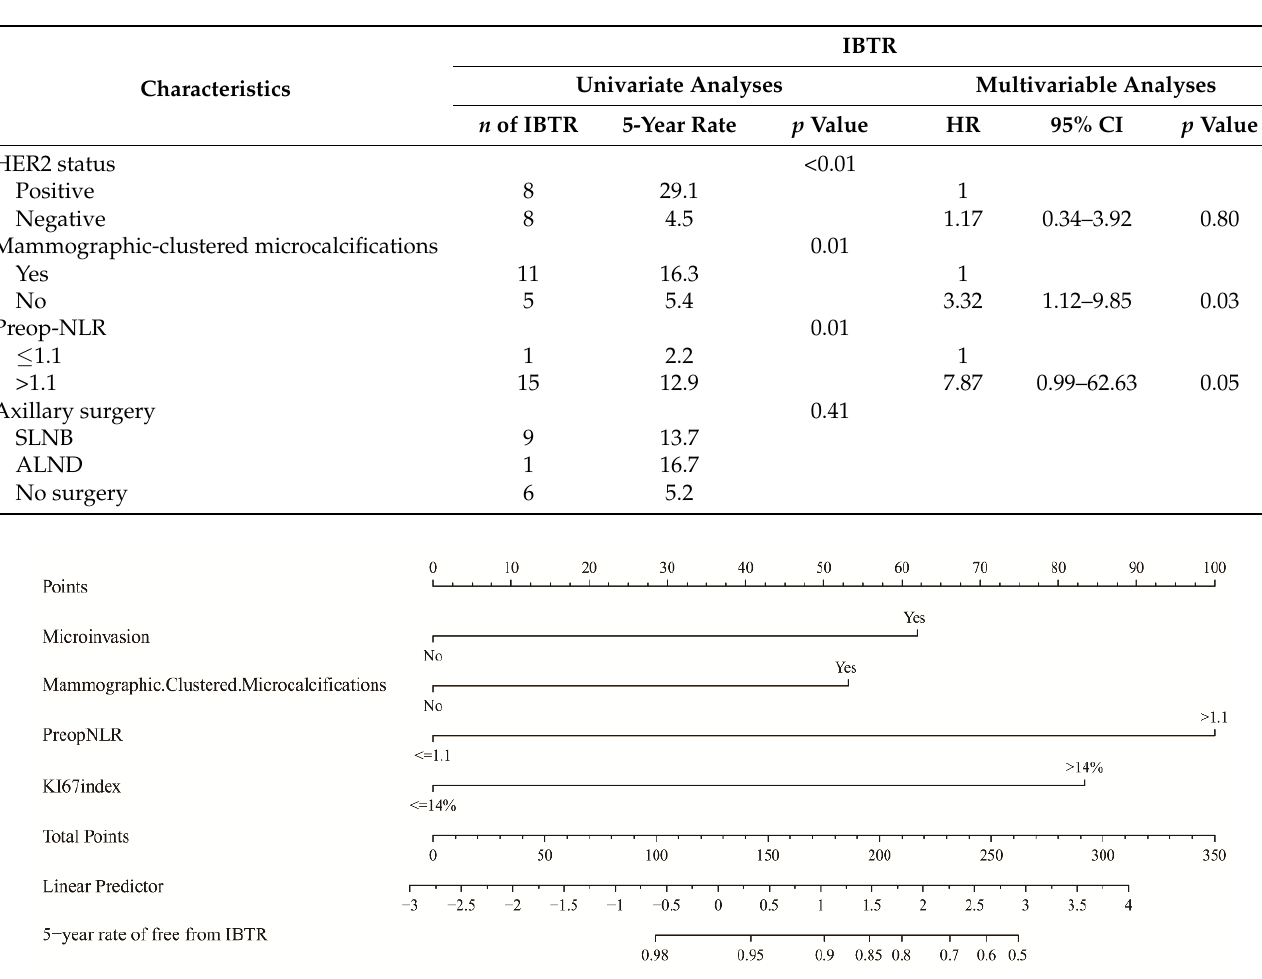
interval (CI) ranging from 0.74 to 0.95 in whole cohort, which indicated a strong model, as shown in Supplemental Figure